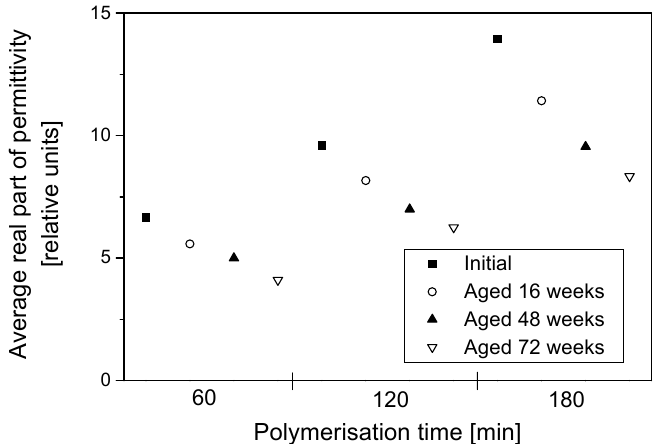
Figure 7. Averages of the real part of permittivity for PPy- p TSA–coated Nylon-Lycra during degradation during aging for three different polymerisation times (60, 120 and 180 min). p TSA concentration: 0.018 mol/L.